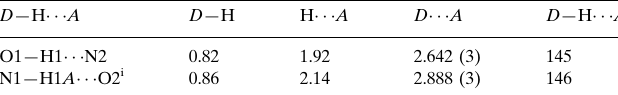
Hydrogen-bond geometry (A˚ , (cid:1)